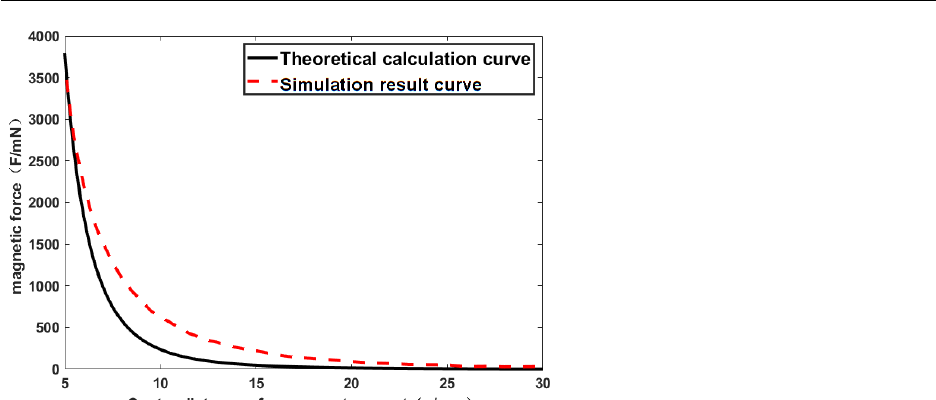
Figure 3. Comparison of theoretical and simulated curves of permanent magnet center distance and magnetic force.